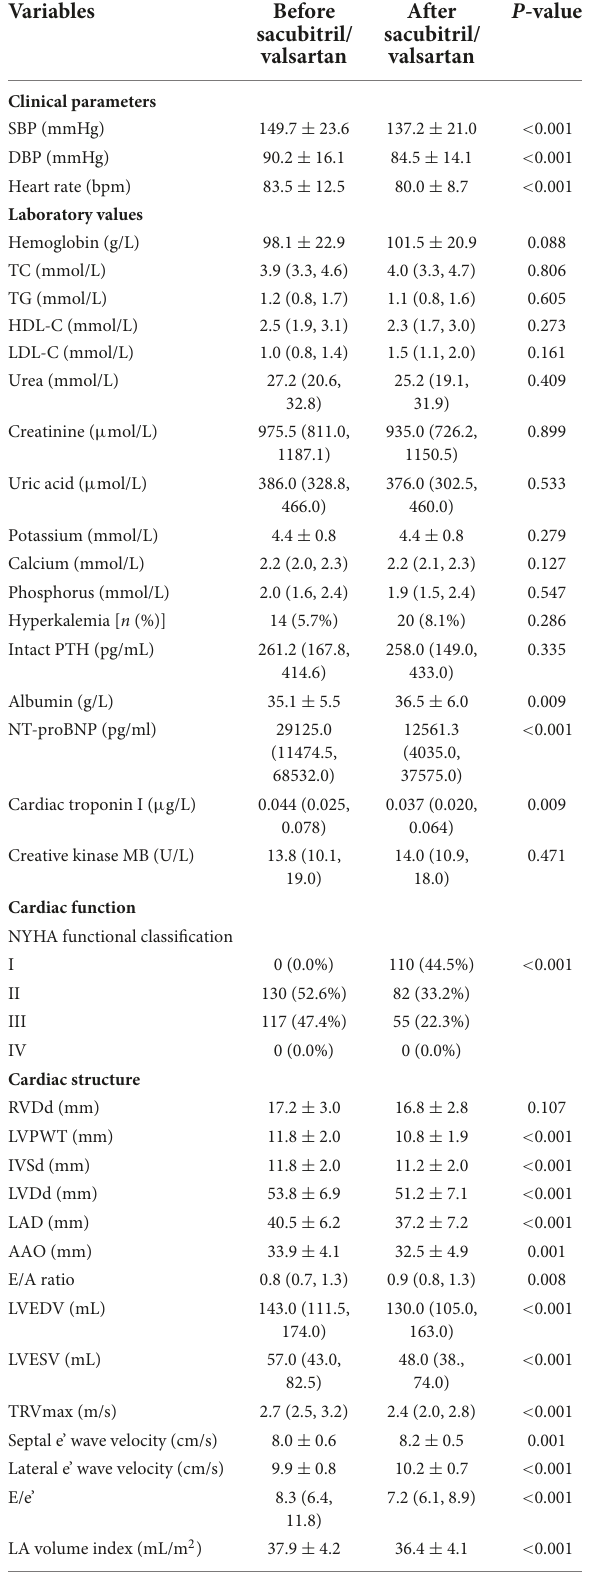
TABLE 2 Comparisons of the characteristics of patients undergoing hemodialysis with HFpEF before and after initiating sacubitril/valsartan with observation period of 3–12